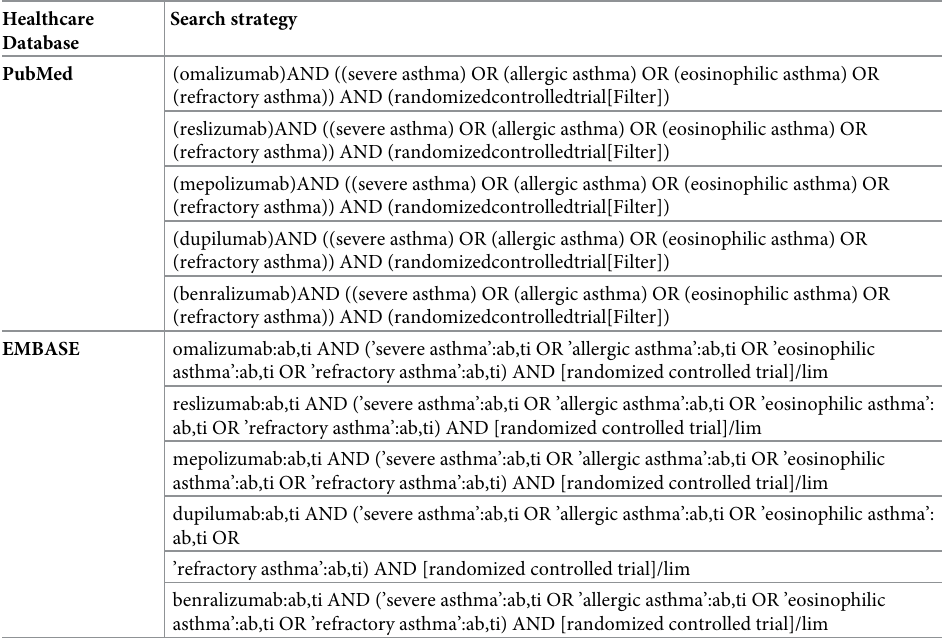
Table 1. Complete search strategy for different